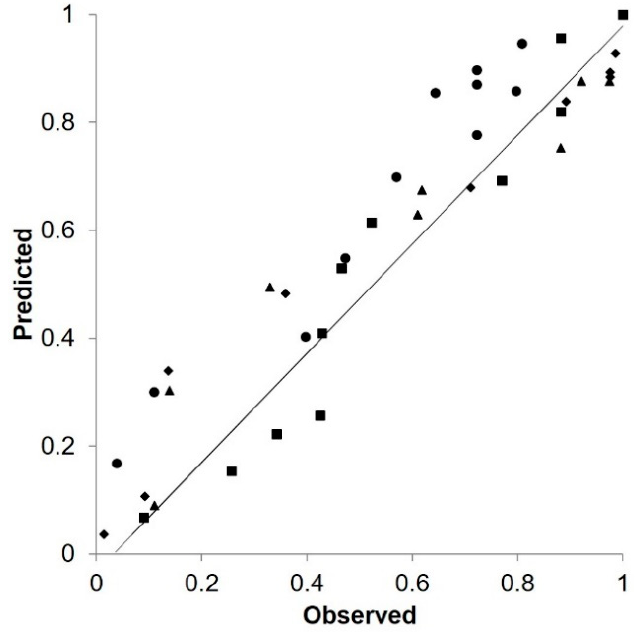
Figure 8. Plots of predicted versus observed values of Ascochyta blight severity for four monitoring locations and years: Poggiorsini, Southern Italy, in 2019 ( ● ); University of Adelaide’s Waite Campus, Australia, in 1996 ( ■ ); University of Adelaide’s Waite Campus, Australia, in 1997 ( ♦ ); and University of Adelaide’s Waite Campus, Australia, in 1998 ( ▲ ). Predicted refers to the predicted disease infection severity through the growing season and rescaled to the final value of the year. Observed refers to the observed disease severity rescaled to the final value of the year.